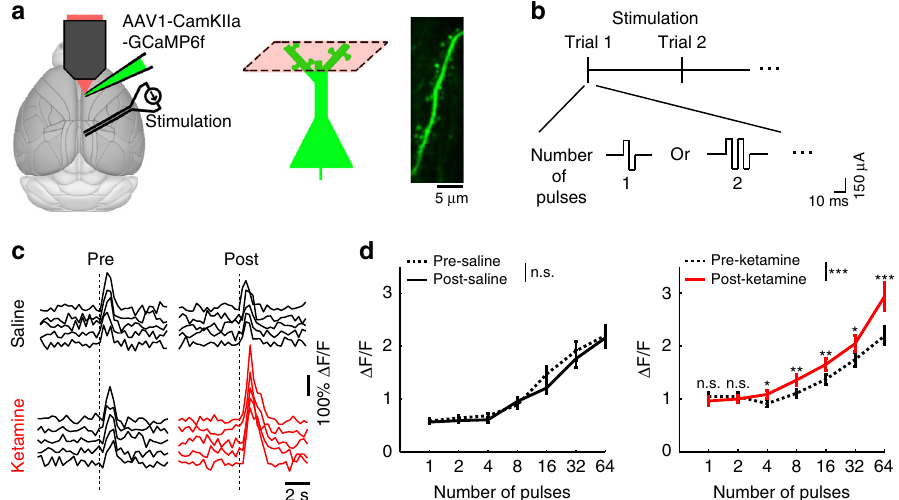
Fig. 4 Ketamine increases synaptically evoked calcium responses in dendritic spines. a Schematic of experimental setup and imaging location. Right, an in vivo two-photon image of GCaMP6f-expressing apical dendritic spines in the super fi cial layer of Cg1/M2. b Protocol for the RSC stimulation. c Fluorescence transients in dendritic spines in Cg1/M2 in response to electrical stimulation of the retrosplenial cortex (RSC). Each trace shows a single 32-pulse-stimulation trial during pre-injection (left) or post-injection (right) period. One example spine was plotted for saline injection (black), and another example spine was plotted for ketamine injection (red). Dashed line, time of stimulation onset. d Trial-averaged spine calcium responses as a function of the number of stimulation pulses applied in a trial, for pre-injection (dashed line) vs. post-injection period (solid line) and for saline (black line) vs. ketamine (10 mg.kg) injection (red line). A three-way mixed ANOVA was performed with drug (saline, ketamine) as a between-subjects factor, and stimulation levels (1, 2, 4, 8, 16, 32, 64) and epoch (pre-injection, post-injection) as within-subjects factors. A three-way interaction was signi fi cant (F(6,2364) = 5.6, P = 9 × 10 − 6 ). A subsequent two-way mixed ANOVA was performed separately on the saline and ketamine datasets, which showed a signi fi cant two-way interaction between epoch (pre vs. post) and stimulation levels for ketamine (F(6,1146) = 6.6, P = 7 × 10 − 7 ), but not for saline (F(6,1218) = 20.0, P = 0.06). Post-hoc Tukey-Kramer test on the ketamine dataset indicated signi fi cantly elevated spine responses for post-injection vs. pre-injection for stimulation pulse numbers of 4 ( P = 0.01), 8 ( P = 0.007), 16 ( P = 0.008), 32 ( P = 0.02), and 64 ( P = 9 × 10 − 5 ). Line, mean ± s.e.m. For saline, n = 204 dendritic spines from 4 animals. For ketamine, n = 192 dendritic spines from 4 animals. Refer to Supplementary Fig. 5f for full distribution. * P < 0.05; ** P < 0.01; *** P < 0.001; n.s., not signi fi cant. Error bars,